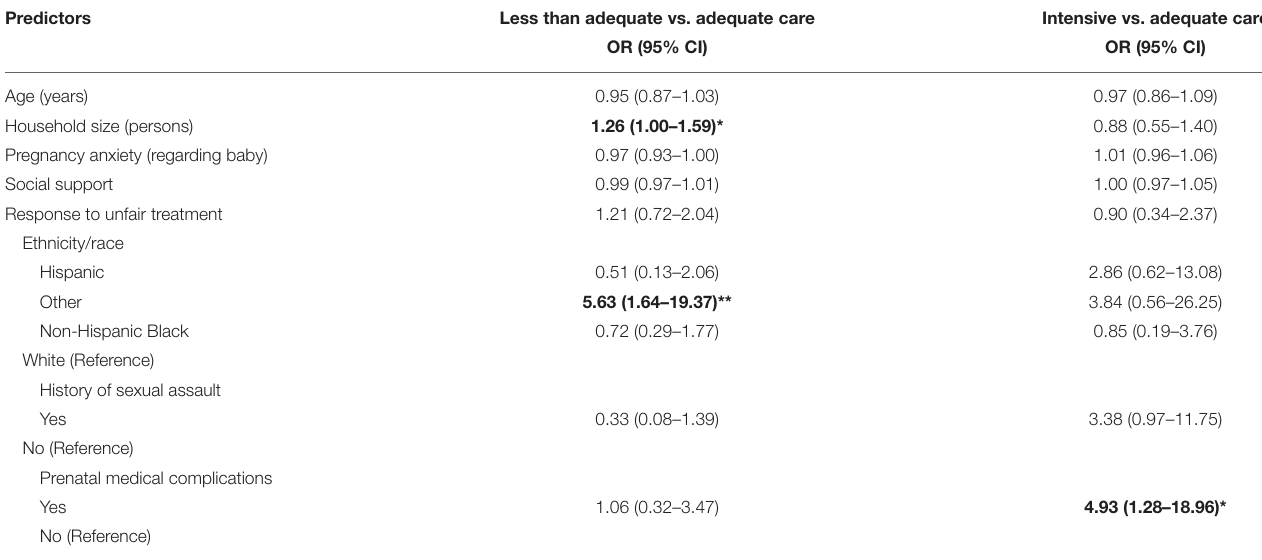
Predictors Less than adequate vs. adequate